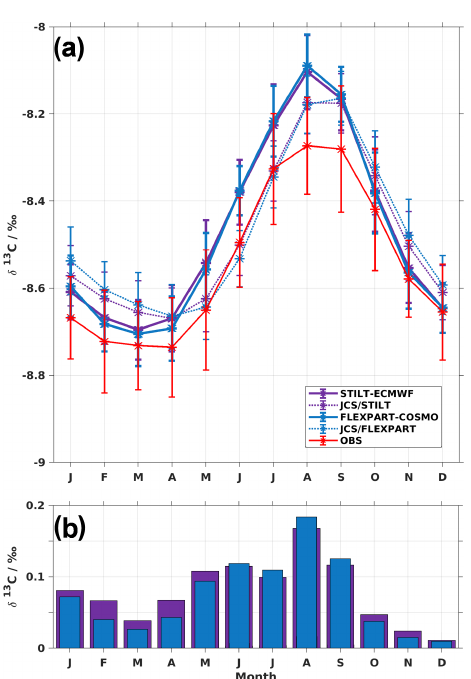
Figure 7. (a) Multi-annual monthly means of 3-hourly model- based and observed atmospheric δ 13 C–CO 2 for the years 2012– 2015. Error bars represent 1SD of the multi-annual means and re- flect the year-to-year variability for 2012–2015. (b) Difference be- tween simulations (sim) and observations